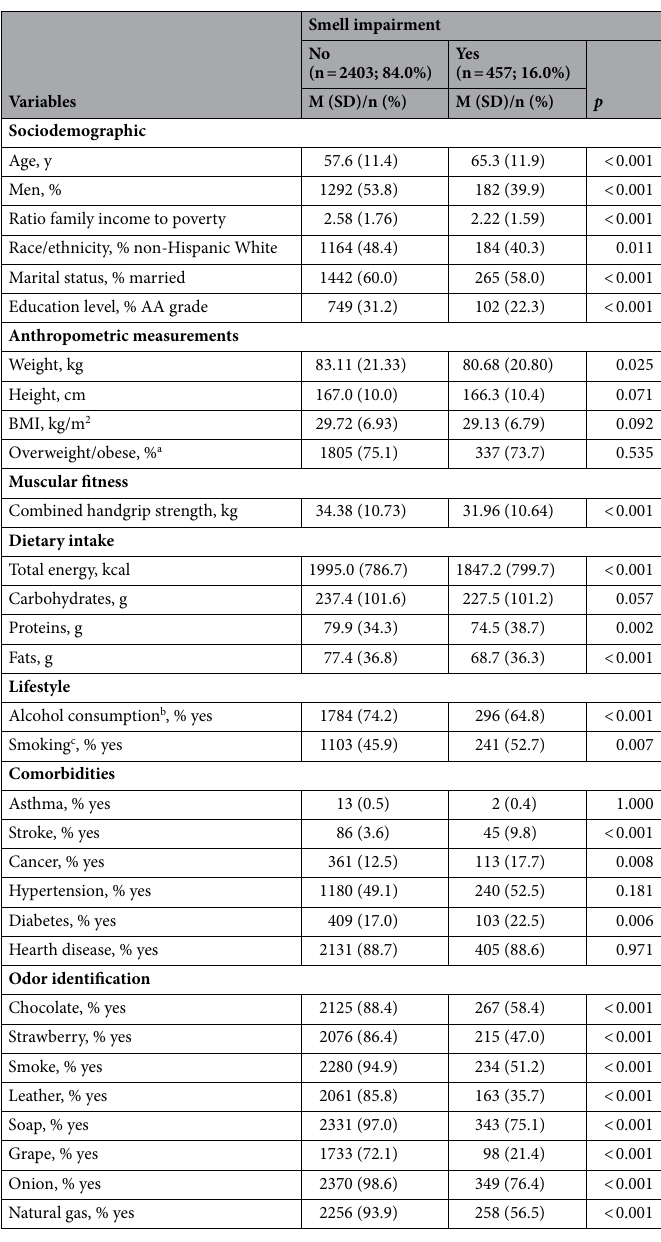
Table 1. Characteristics of participants. Data presented as mean (standard deviation) or numbers (percentages). a Nutritional status was defined following the Expert Panel on the Identification, Evaluation, and Treatment of Overweight in Adults criteria 21 . b Alcohol consumption was determined by the question “Had at least 12 alcohol drinks per year?”. c Smoking was determined by the question “Smoked at least 100 cigarettes in